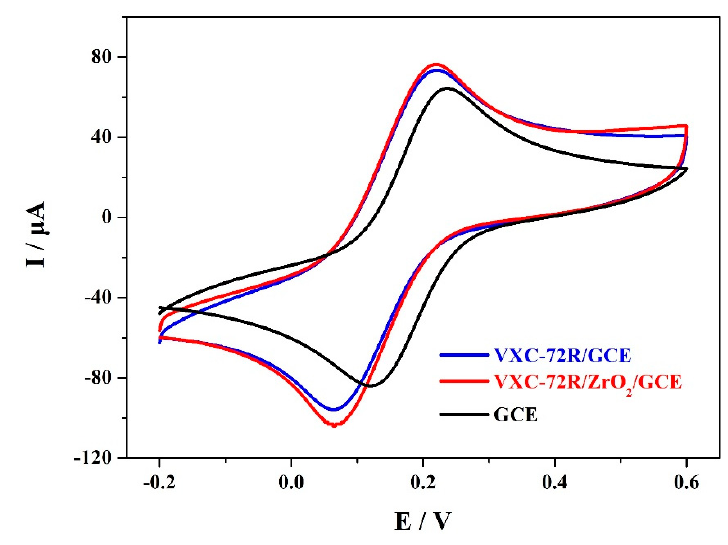
Figure 3. Cyclic voltammetry (CV) curves of the electrochemical sensors based on the undecorated glassy carbon electrodes (GCEs), VXC-72R/GCEs, and VXC-72R/ZrO 2 /GCEs in 5 mM of K 3 [Fe(CN) 6 ]/K 4 [Fe(CN) 6 ] solution containing 0.1 mM KCl.